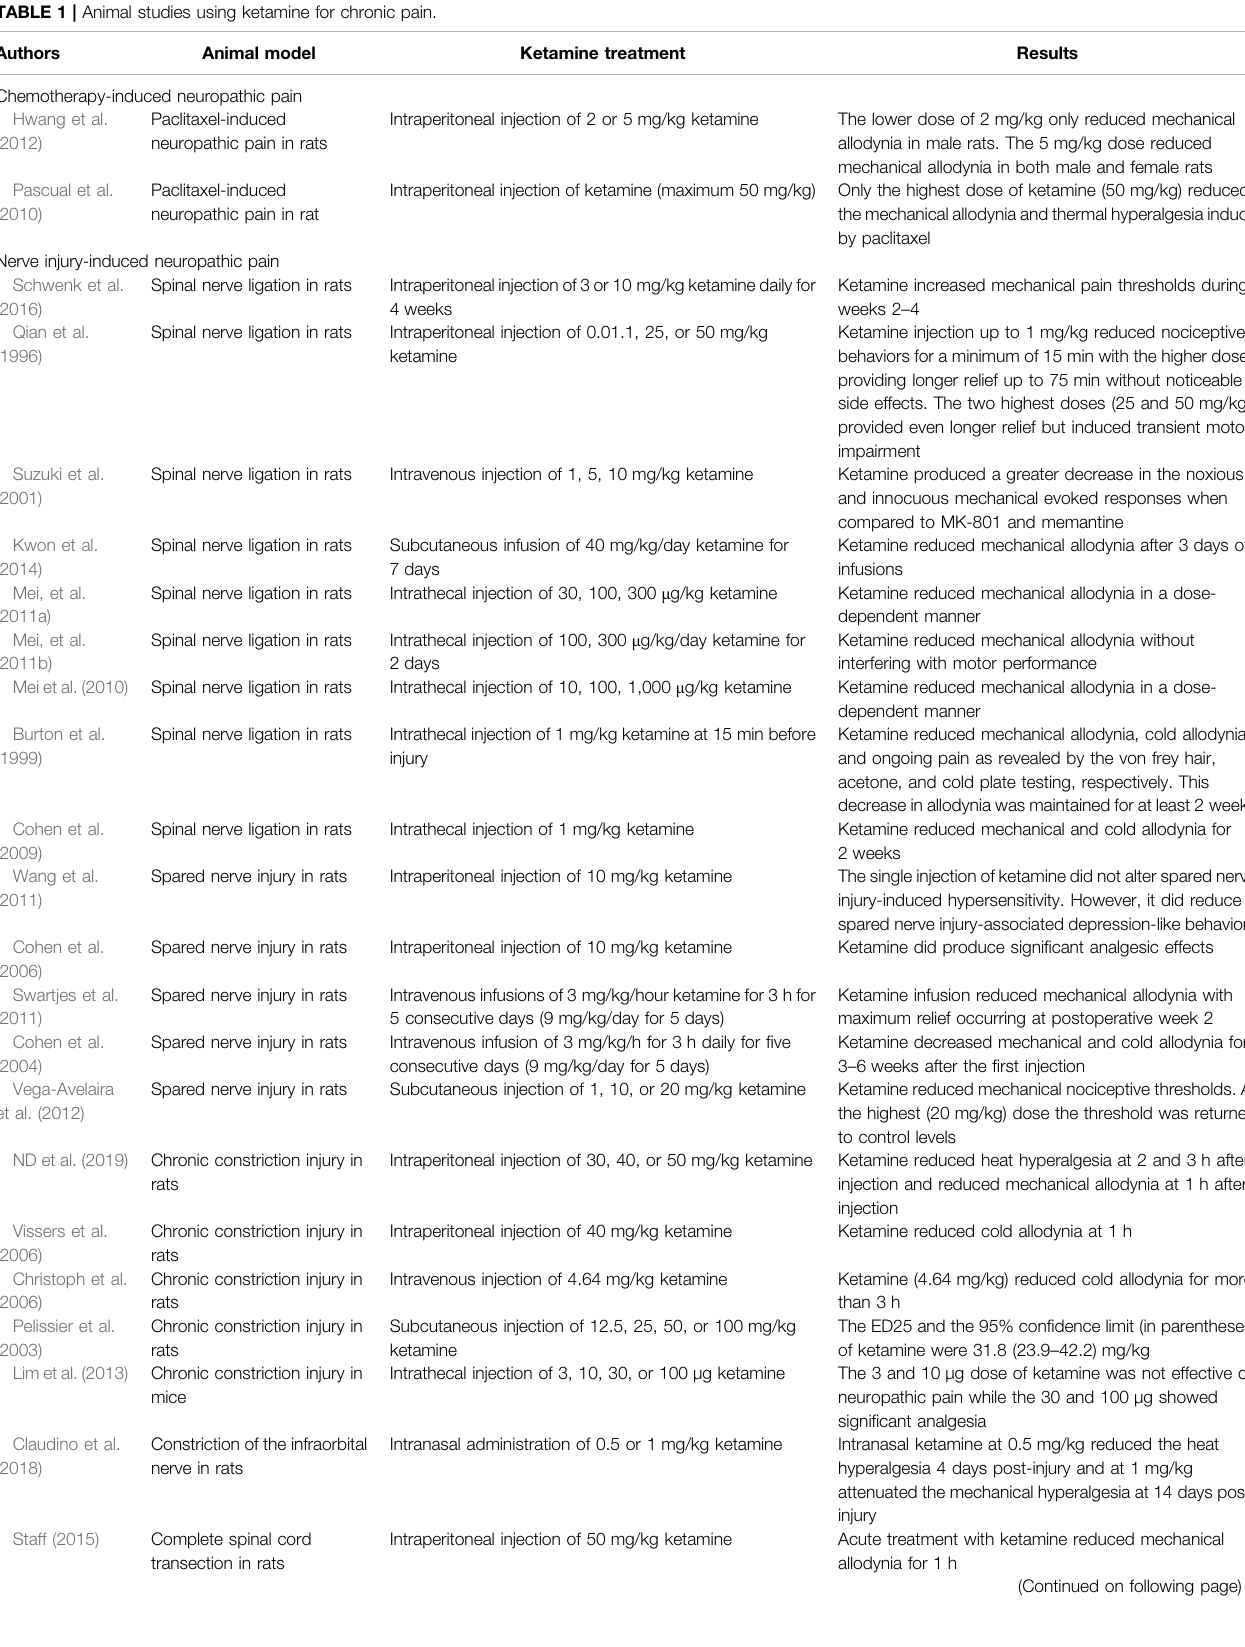
TABLE 1 | Animal studies using ketamine for chronic